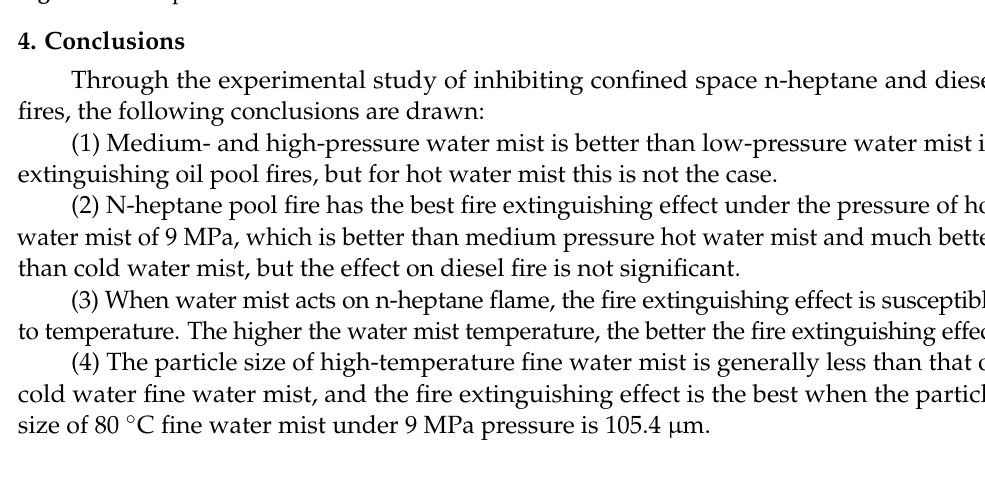
Flame diagram under the action of hot and cold water mist for 8 s Figure 11. Comparison of flames at different times under the action of hot and cold water